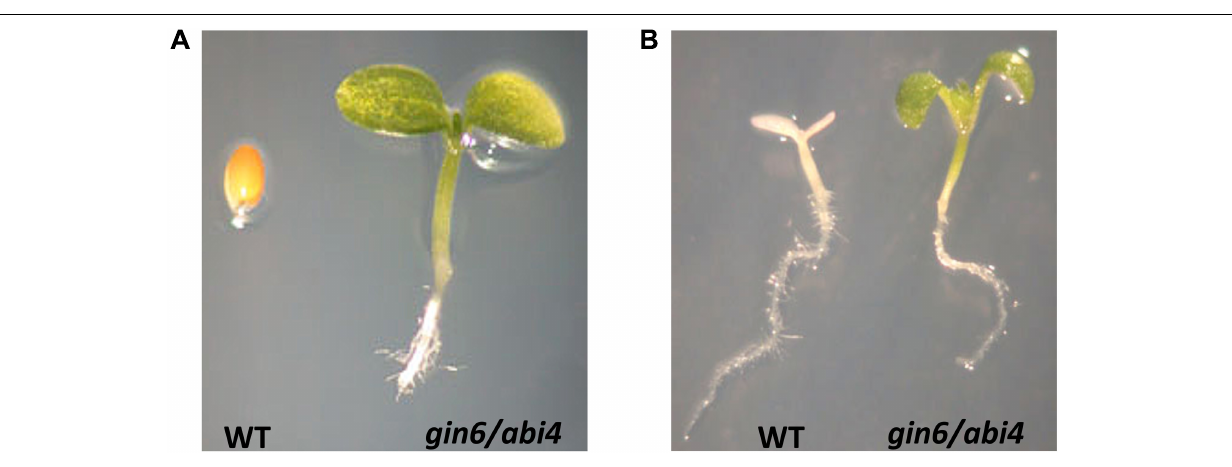
containing 6.5% glucose (Glc), the development of wild-type plants arrests, and they do not accumulate chlorophyll in contrast to the abi4 / gin6 mutant, which continues growing and displays a green phenotype and cotyledon expansion (B)